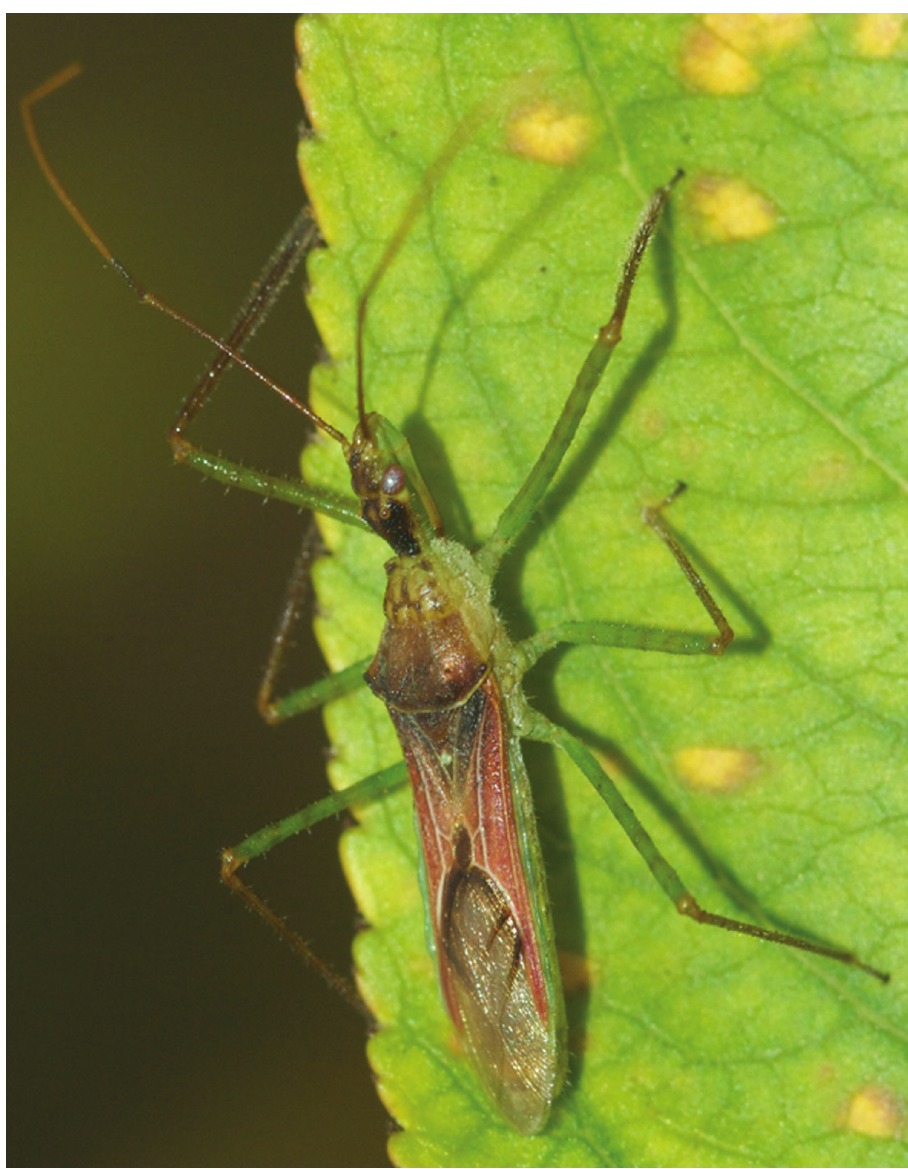
Figure 1. Zelus renardii Kolenati, 1856 (Reduviidae, Harpactorinae). Photo K. Kamppeter. Determi- nation L.